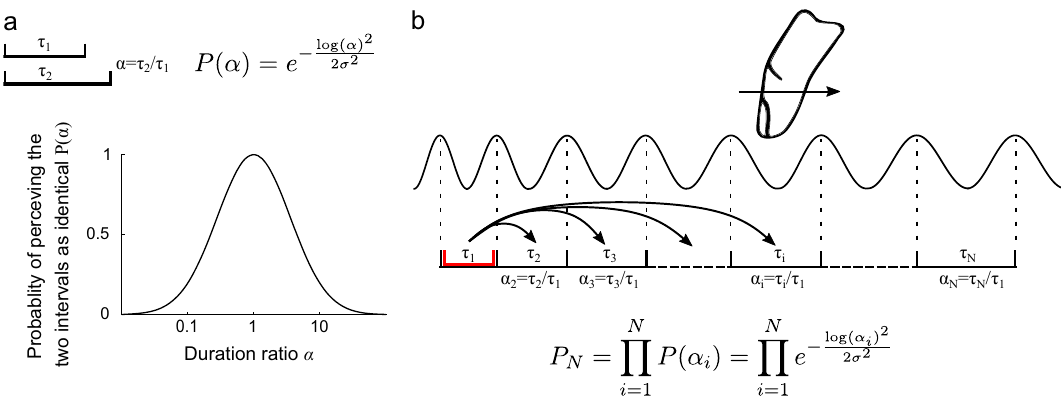
Figure 3. Model of tempo perception applied to haptics. ( a ) Basic principle of the model: the probability P of perceiving two intervals as having the same duration follows a log-Gaussian function with respect to the ratio between the two interval durations α . ( b ) Application of the model: the haptic stimulus is converted into a pulse train. The theory of comparison with an internal interval with accretion is then applied to the intervals τ i to calculate the probability of perceiving the